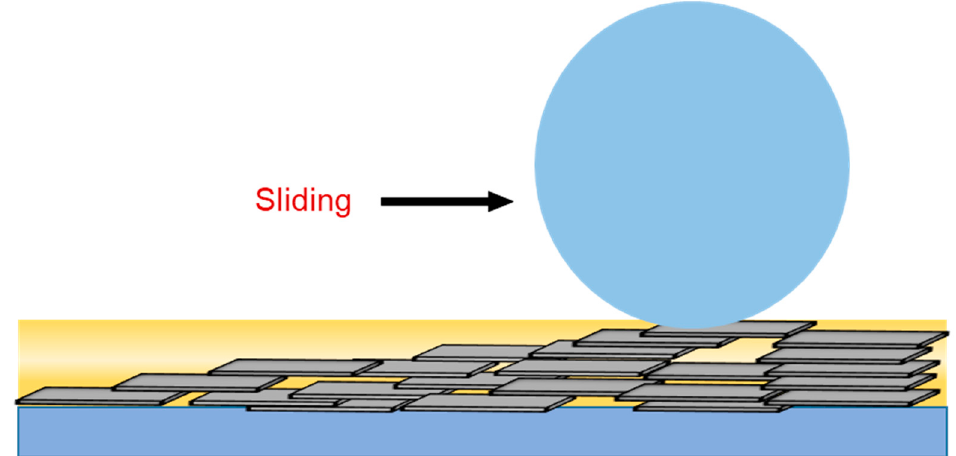
Figure 4. Interlayer slip mechanism of two-dimensional nanomaterials.